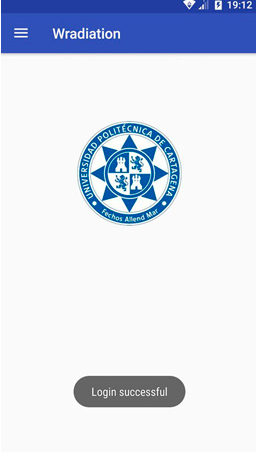
Figure 10. Login successful.